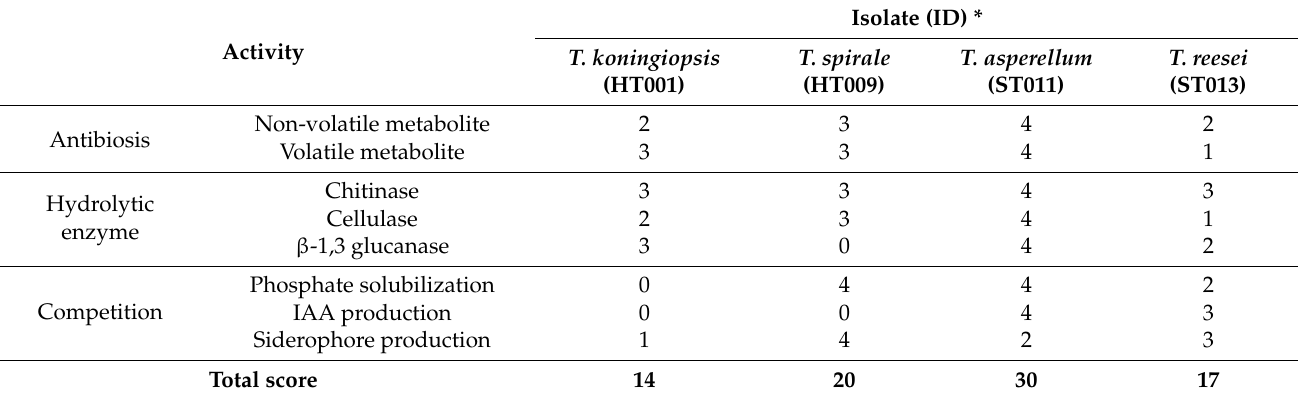
Table 10. Scoring of the biochemical assays performed by Trichoderma